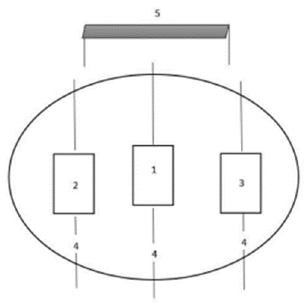
Figure 1. Representative scheme. 1—Test platform where each subject performed data collection; 2—Platform for creating turbulence on one side (subject’s right side) and on both sides; 3—Platform for creating turbulence on both sides (subject’s left side); 4—Ropes with moorings to the platform and out of the water; 5—Data collection table to receive the EMG data.